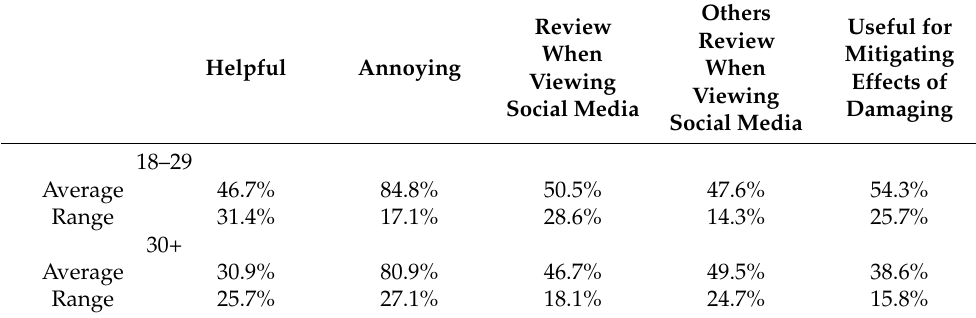
Table 21. Data characteristics—blocking label survey by age group.